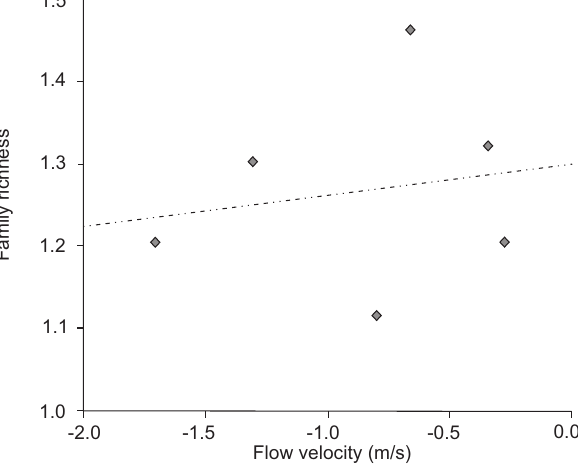
Figure 3. Effect of flow velocity on family richness of the fauna inhabiting stream bryophytes in the Poço D’Anta Biological Re- serve. The axes are in logarithmic